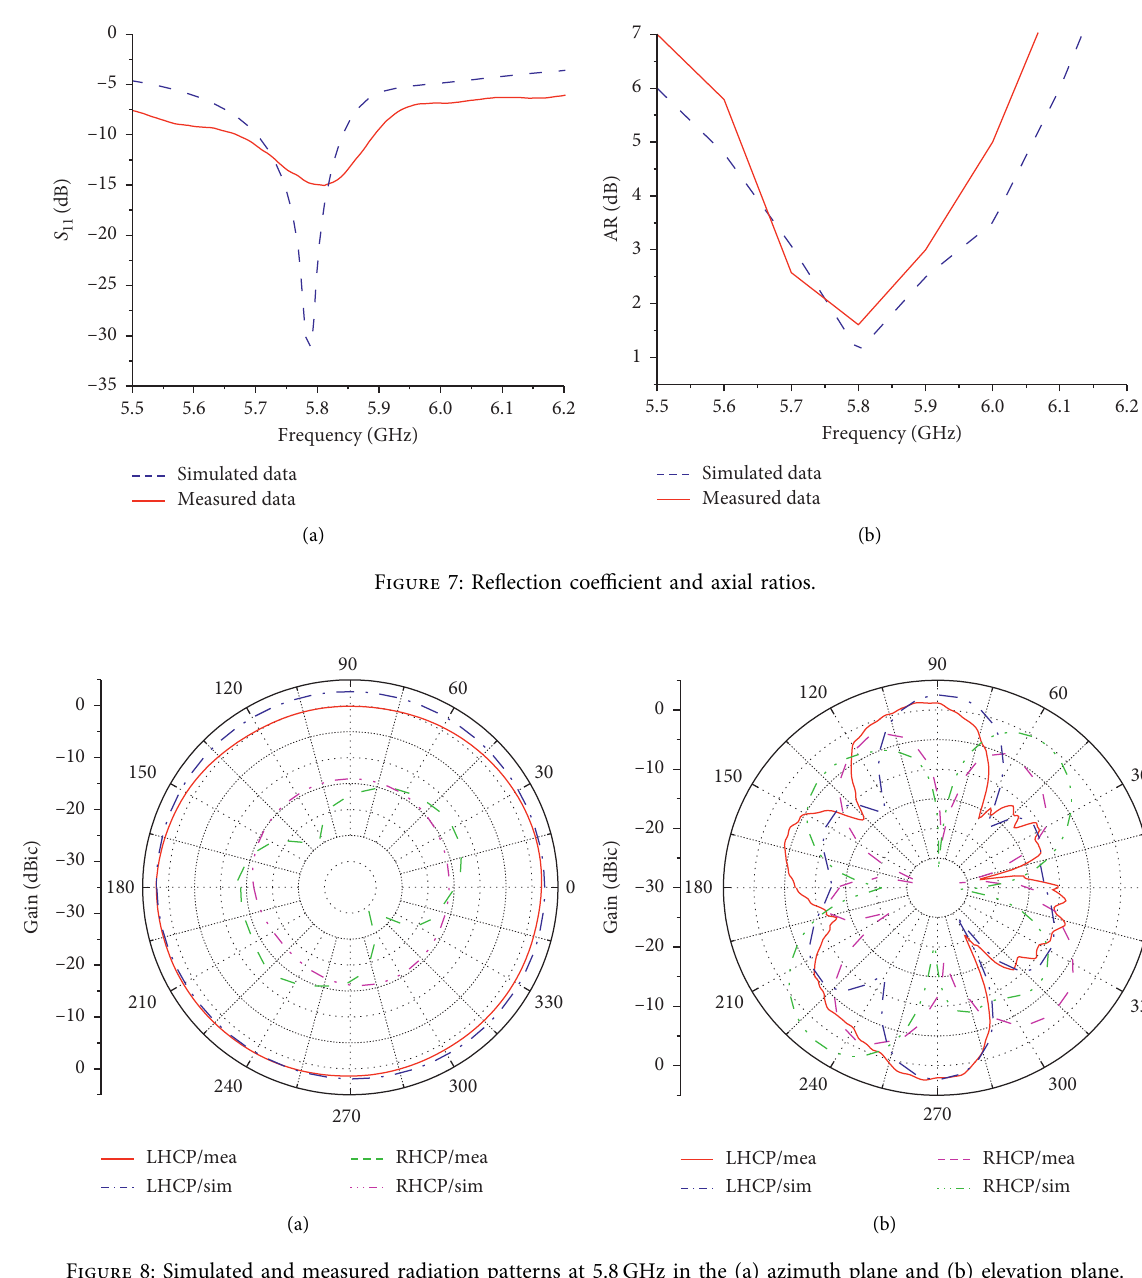
Figure 8: Simulated and measured radiation patterns at 5.8GHz in the (a) azimuth plane and (b) elevation plane.